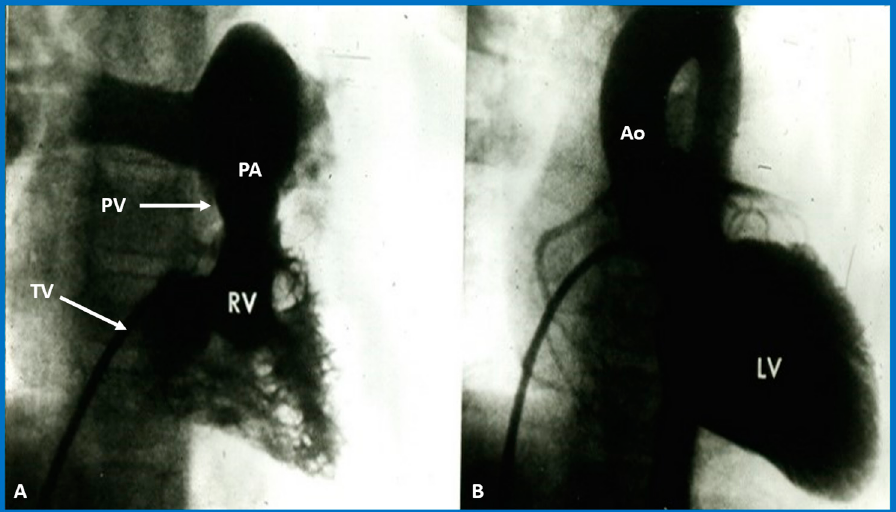
Figure 31. Selected angiographic images demonstrating characteristic features of the right ( A ) and left ( B ) ventricles. The right ventricle (RV) exhibits coarse trabeculations ( A ), while the left ventricle (LV) shows smooth or fine trabeculations ( B ). In addition, the RV exhibits a triangular shape, whereas the LV is a foot-shaped structure. The tricuspid (TV) and pulmonary (PV) valves (arrows in ( A )) are separated by a muscular structure, crista supraventricularis. Aorta (Ao) and pulmonary artery (PA) are labeled. Modified from reference